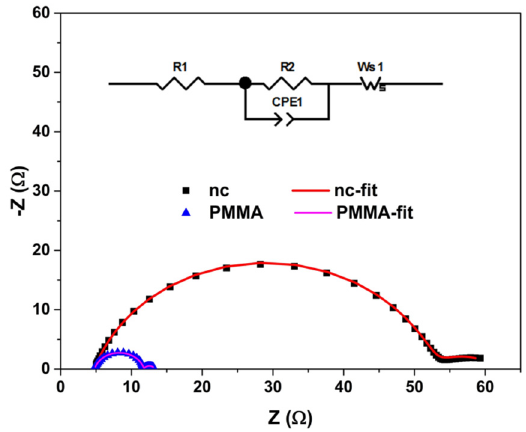
Figure 3. Nyquist plots of symmetrical cells with gel-state electrolytes based on PMMA or nanoclay with equivalent circuit used.